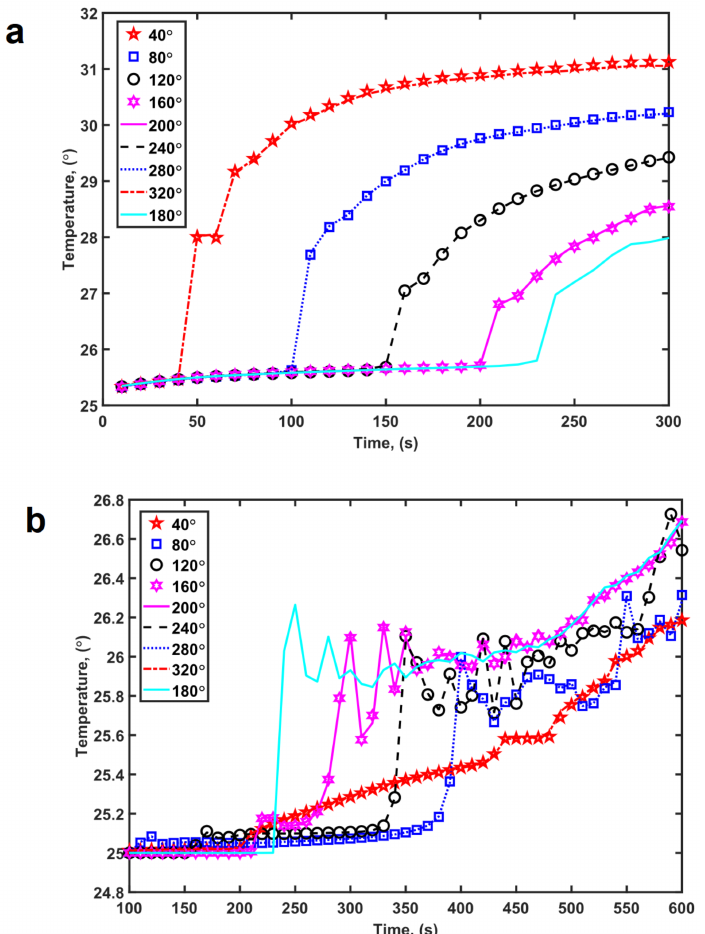
Figure 7. Temporal variation in temperature at points located circumferentially: ( a ) on the surface of the pool, ( b ) at a depth of 50 mm from the